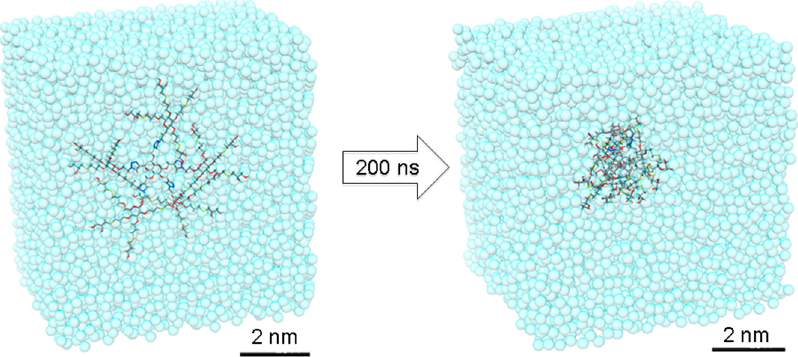
Figure 2. The MD simulation of 16 , starting from an initially fully extended conformation. Dendrimer 16 rapidly rearranges into a 2 nm stable globular shape in water.